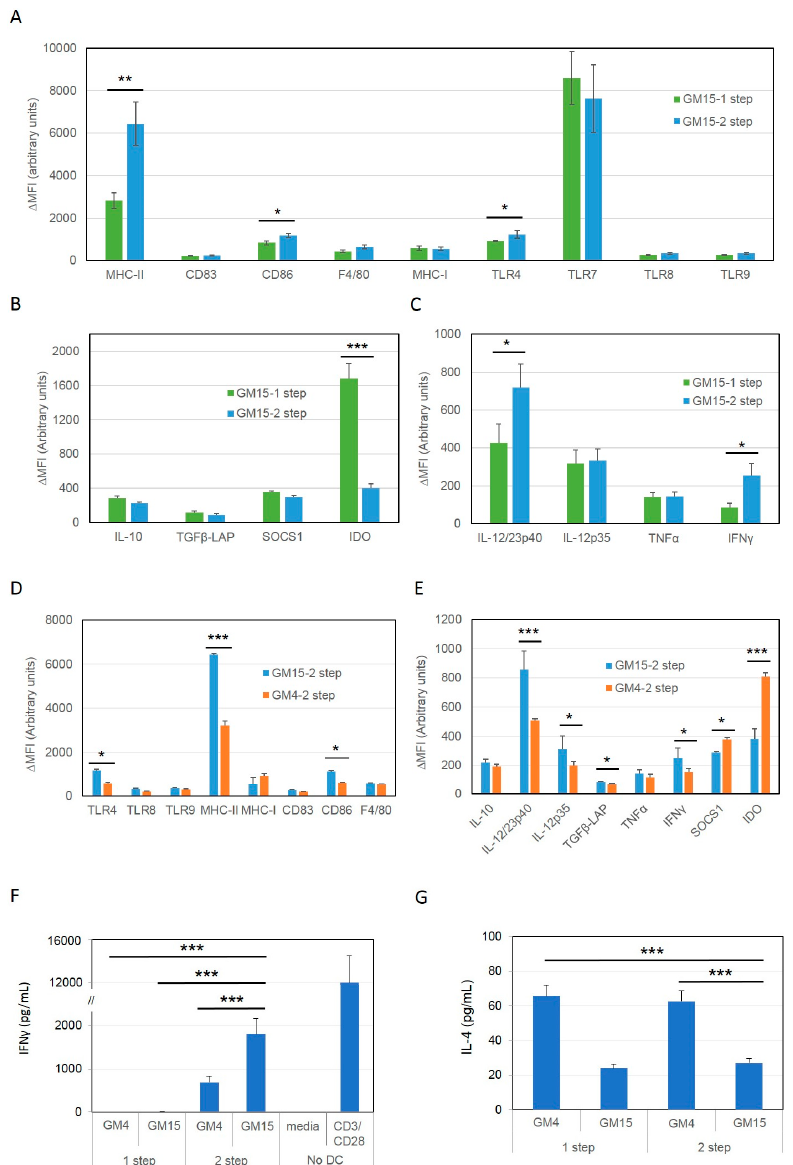
Figure 3. DCs matured with a two-step protocol in the presence of anti-CD40 and anti-IL10R antibodies for 24 h, followed by LPS/IFN γ /CpG stimuli present a more mature phenotype and stimulate a more Th1-skewed T cell response compared to canonical LPS/IFN γ maturation. ( A – E ) Immature antigen-pulsed DCs were obtained in the presence of either IL4 (GM4) or IL-15 (GM15) as reported in Figure 2. Cells were then pulsed with an ID8 tumor cell lysate treated with squaric acid and subsequently matured in the presence of either LPS/IFN γ for 24 h (GM15-1 step, GM4-1 step) or with a cocktail mix containing anti-CD40 and anti-IL-10R for 24 h, followed by a second mix containing LPS, IFN γ and CpG for the subsequent 24hr (GM4-2 step, GM15-2 step). Expression levels of indicated markers were then assessed by antibody staining followed by FACS analysis. The net mean fluorescence intensity ( ∆ MFI = Raw MFI-MFI of Isotype) for each marker is reported in the graph. ( F , G ) IFN γ and IL-4 production measured by ELISA after 24 h co-culturing of splenic T-lymphocytes isolated from tumor bearing animals with the indicated DC formulations. Data are representative of at least 3 independent experiments. Significant differences were assessed with unpaired Student’s t test and indicated with asterisks: * p < 0.05; ** p < 0.01; *** p < 0.005. (CpG: CpG oligonucleotides; DC: dendritic cells; GM-CSF: granulocyte-macrophage colony-stimulating factor; IL-4: interleukin-4; IL-10R: interleukin-10 receptor; IL-15: interleukin-15; IFN- γ : interferon- γ ; LPS: